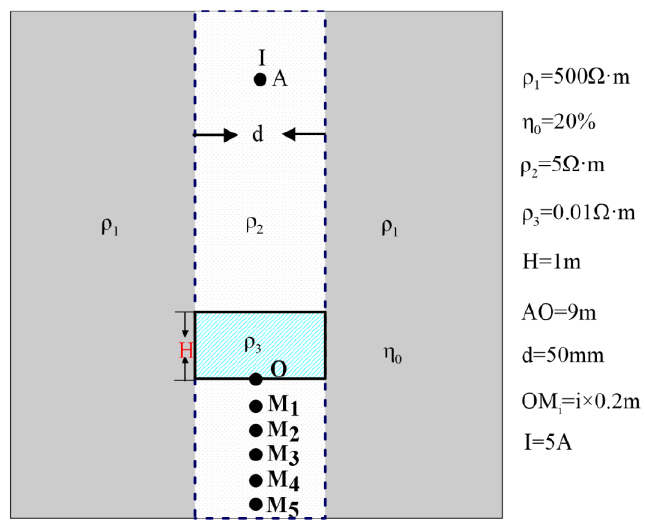
Figure 6. Schematic diagram of the model.